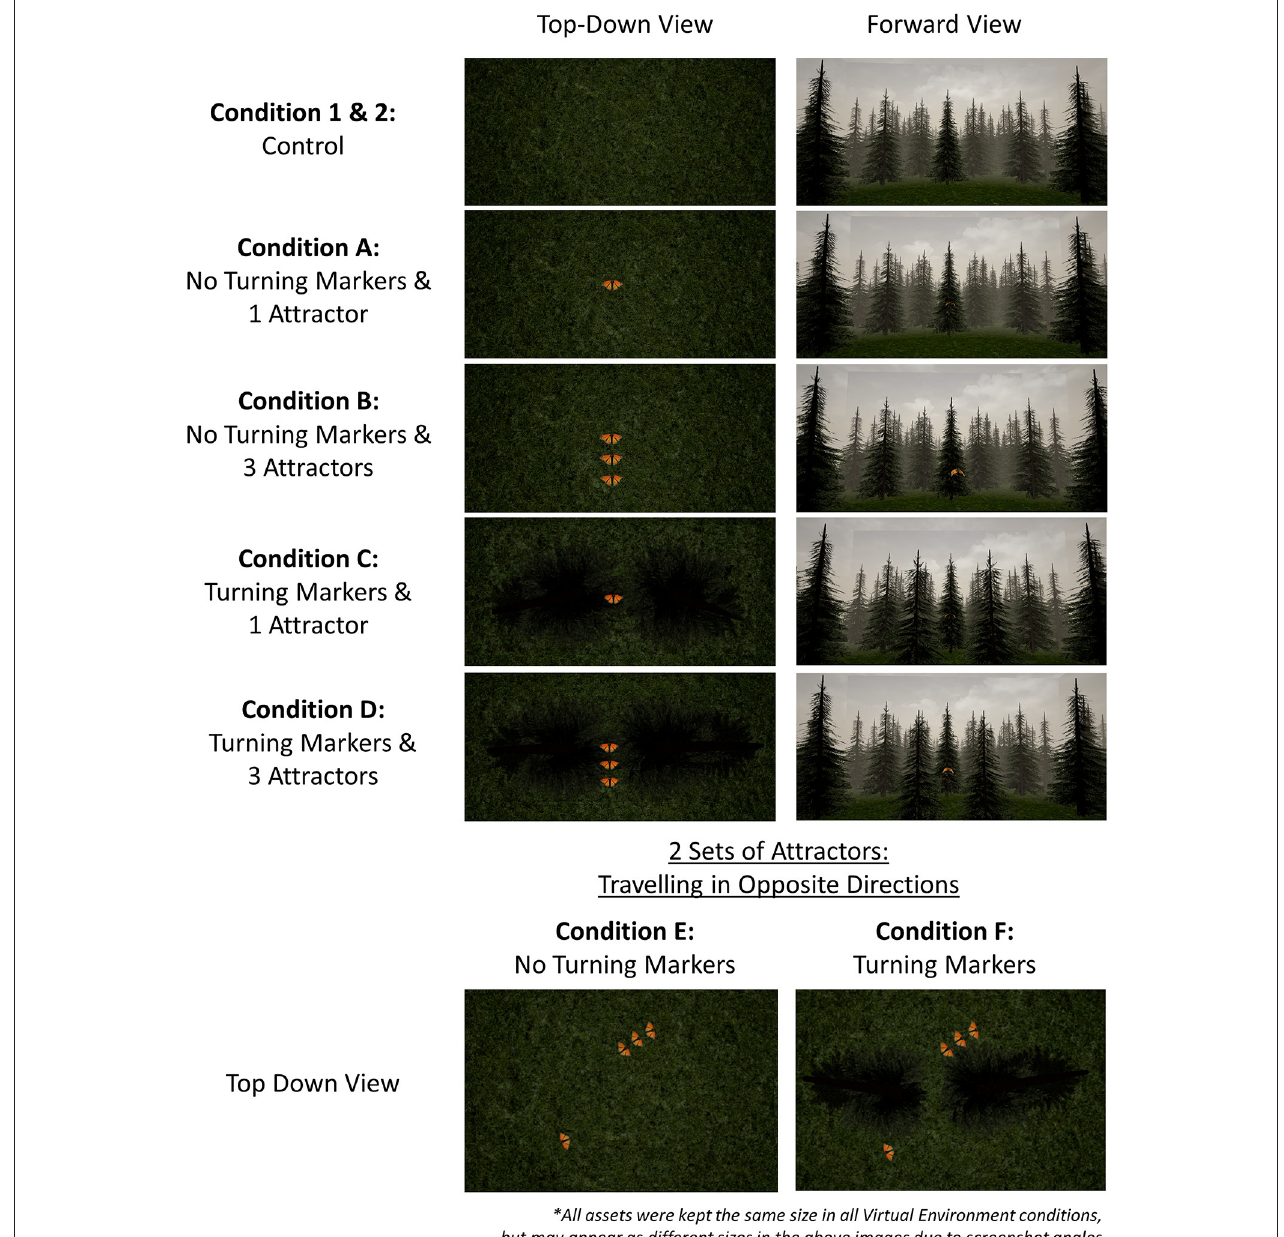
FIGURE 2 | Virtual environment